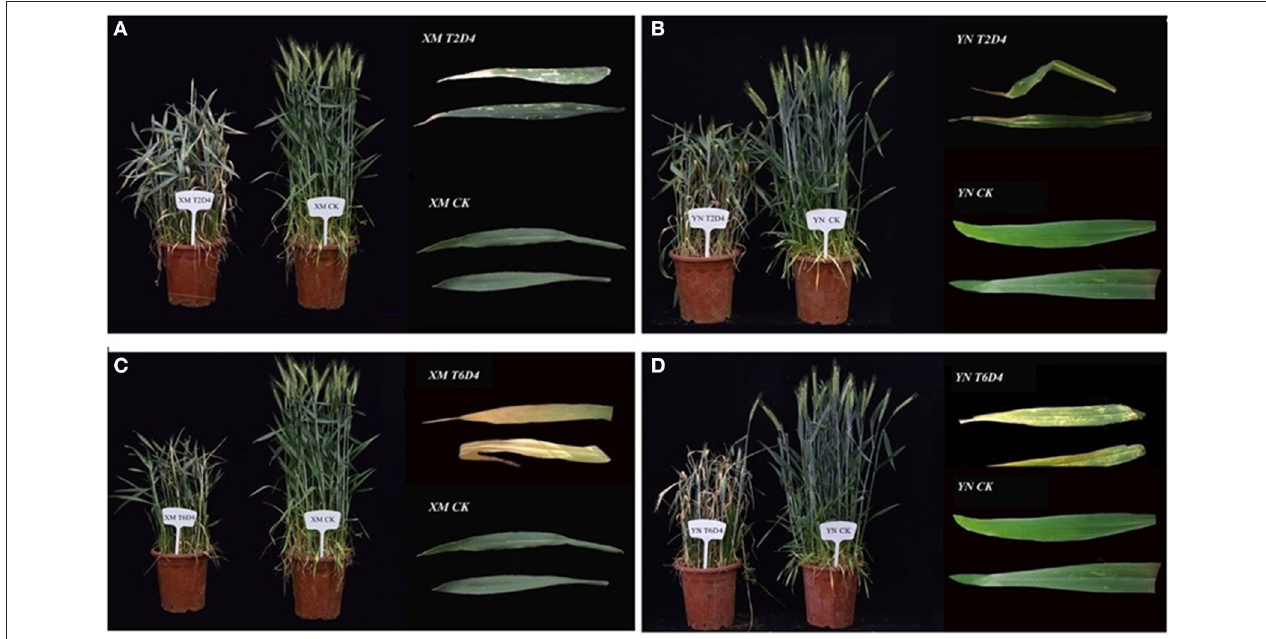
FIGURE 1 | Impacts of low-temperature stress on two winter wheat cultivars, XM and YN (XM: XinMai–Cold Sensitive and YN: YanNong–Cold Tolerant), is shown with the damage induced by cold stress, as compared with control (CK). Wheat cultivars with treatments (A) XMT2D4 [T2 = 4 ◦ C, D4 = 12 h/3 d], (B) YNT2D4 [T2 = 4 ◦ C, D4 = 12 h/3 d], (C) XMT6D4 [T6 = − 4 ◦ C, D4 = 12 h/3 d], and (D) YNT6D4 [T6 = -4 ◦ C, D4 = 12 h/3 d) has clearly exhibited the damage induced by cold stress, as compared with control (CK) treatments of XM and YN. Growth Conditions: Experiment grown under field conditions, before the heading stage shifted to the controlled